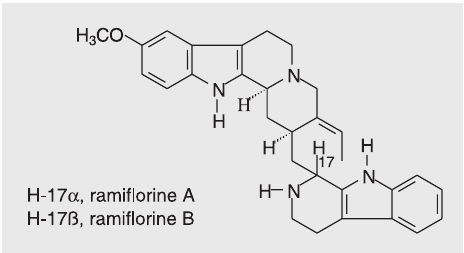
Figure 1. Structures of ramiflo- rines A and